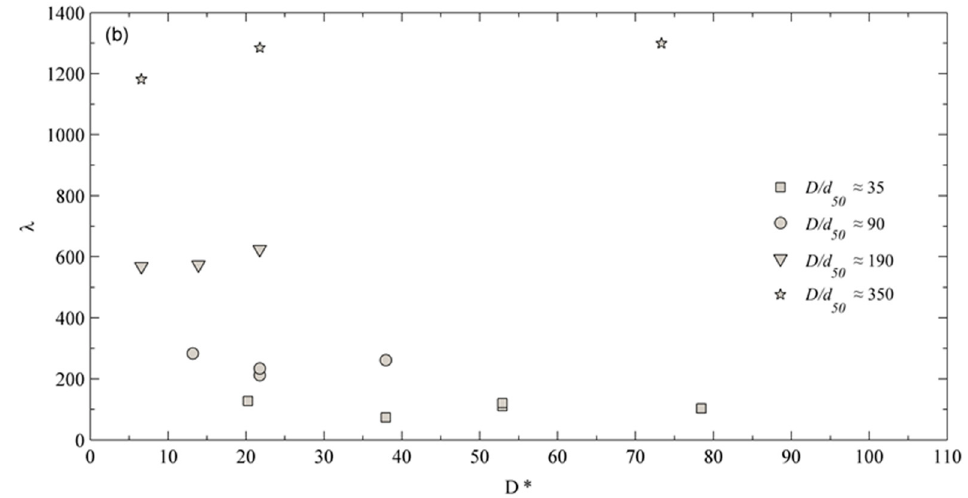
Figure 4. ( a ) Relative scour evolution over W * for the four categorized classes; ( b ) λ calibrated values in function of the dimensionless particle diameter D*. in function of the dimensionless particle diameter D*.